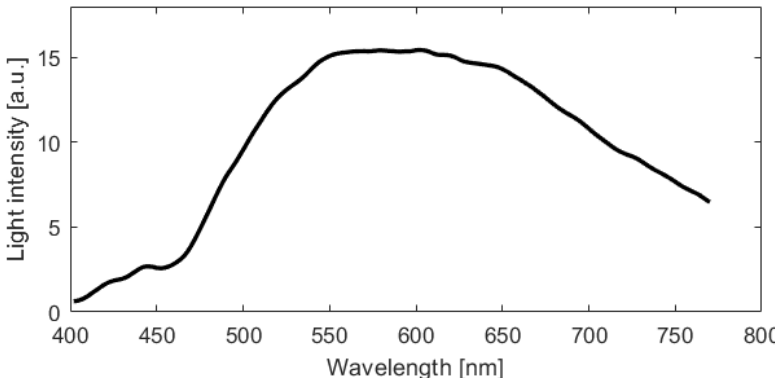
Figure 14. Halogen source intensity